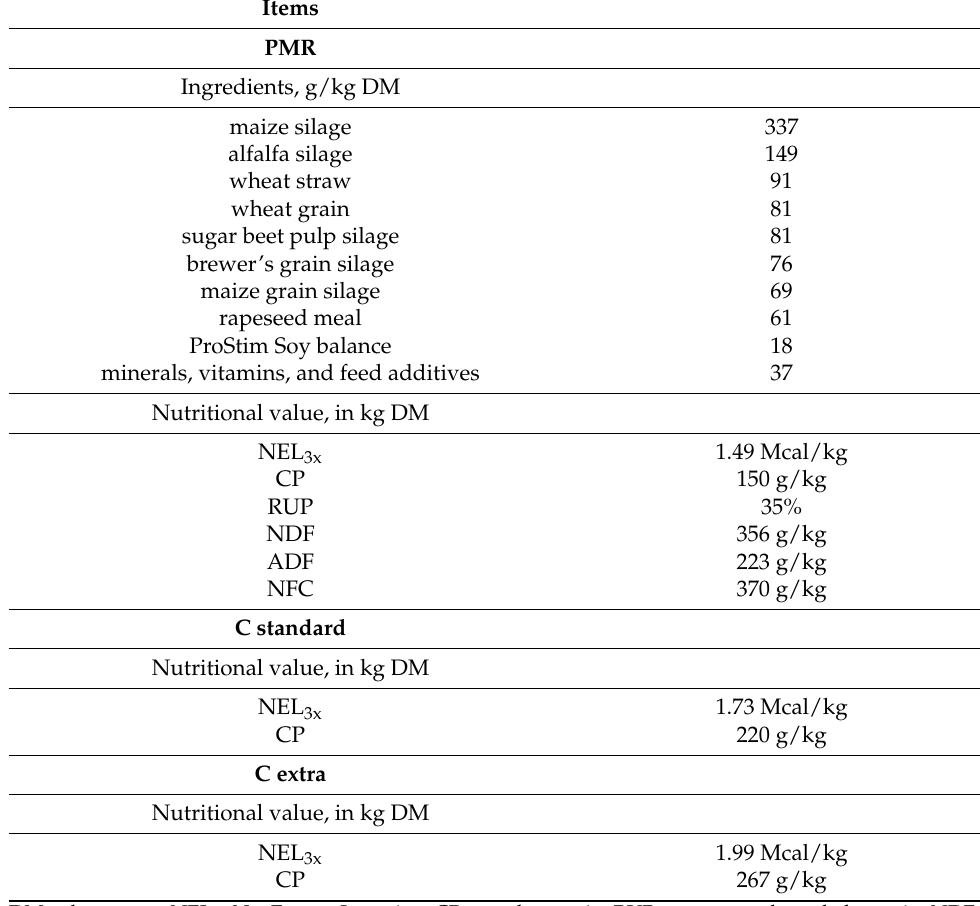
Table 1. Average ingredients and nutrient composition of the experimental partial mixed ration diet (PMR) and concentrates (C standard, C extra). Items PMR Ingredients, g/kg DM maize silage 337 alfalfa silage 149 wheat straw